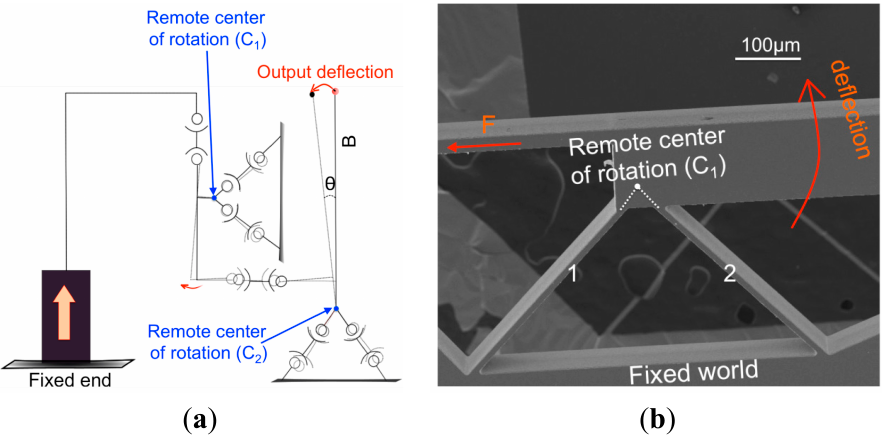
Figure 4. ( a ) Kinematics of the displacement amplification mechanism. The circles represent one-degree-of-freedom rotation pivot joints. The bars represent rigid links. The dash lines indicate the kinematics being operated. The end-effector is body B. ( b ) Scanning